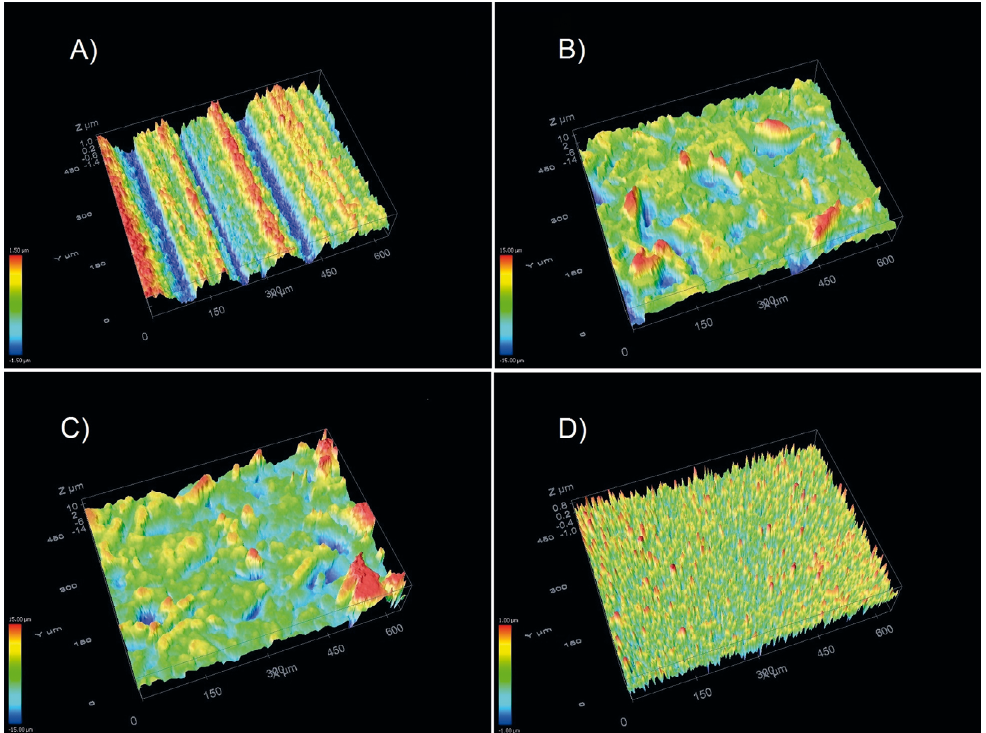
Figure 5. Images obtained by confocal profilometer of morphology sample surface in 600 X 600 X10 µm scanning area. (A) “S” sample (b) “R” sample (c) “D” sample and (d) “Si”